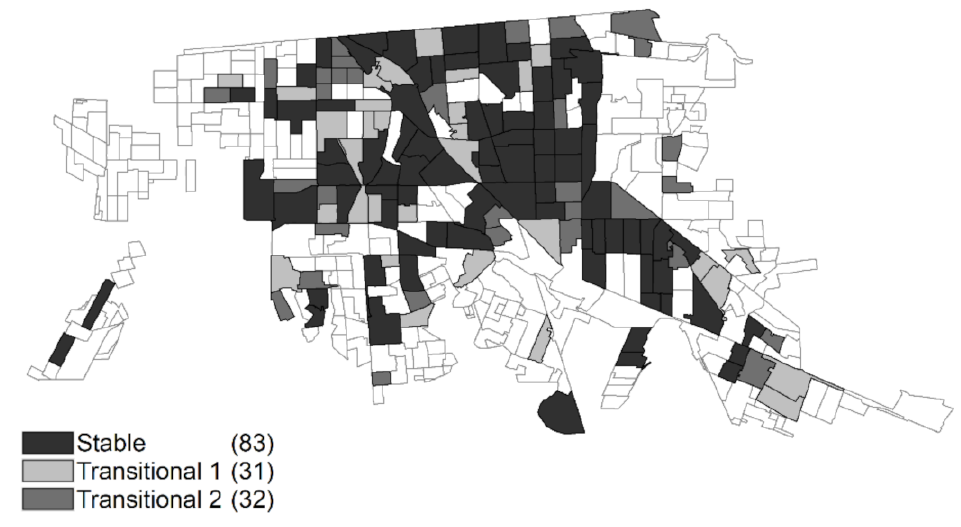
Figure 4. Stable and transitional hot spots in